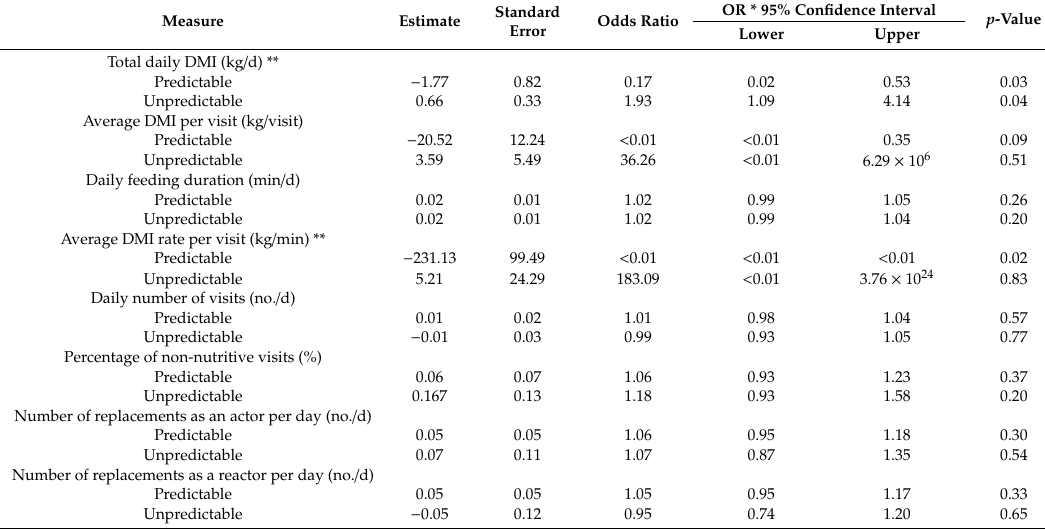
Table 1. Odds ratio (OR) of postpartum cytological endometritis given the total daily dry matter intake (DMI; kg / d), average DMI per visit (kg / visit), daily feeding duration (min / d), average DMI rate per visit (kg / min), daily number of visits (no. / d), percentage of non-nutritive visits (%), and number of social replacements as an actor and reactor per day (no. / d) for pregnant Holstein cows in either a predictable and non-competitive social environment (‘predictable’) or an unpredictable and competitive social environment (‘unpredictable’) for the four weeks before calving (predictable: n = 23; unpredictable: n =